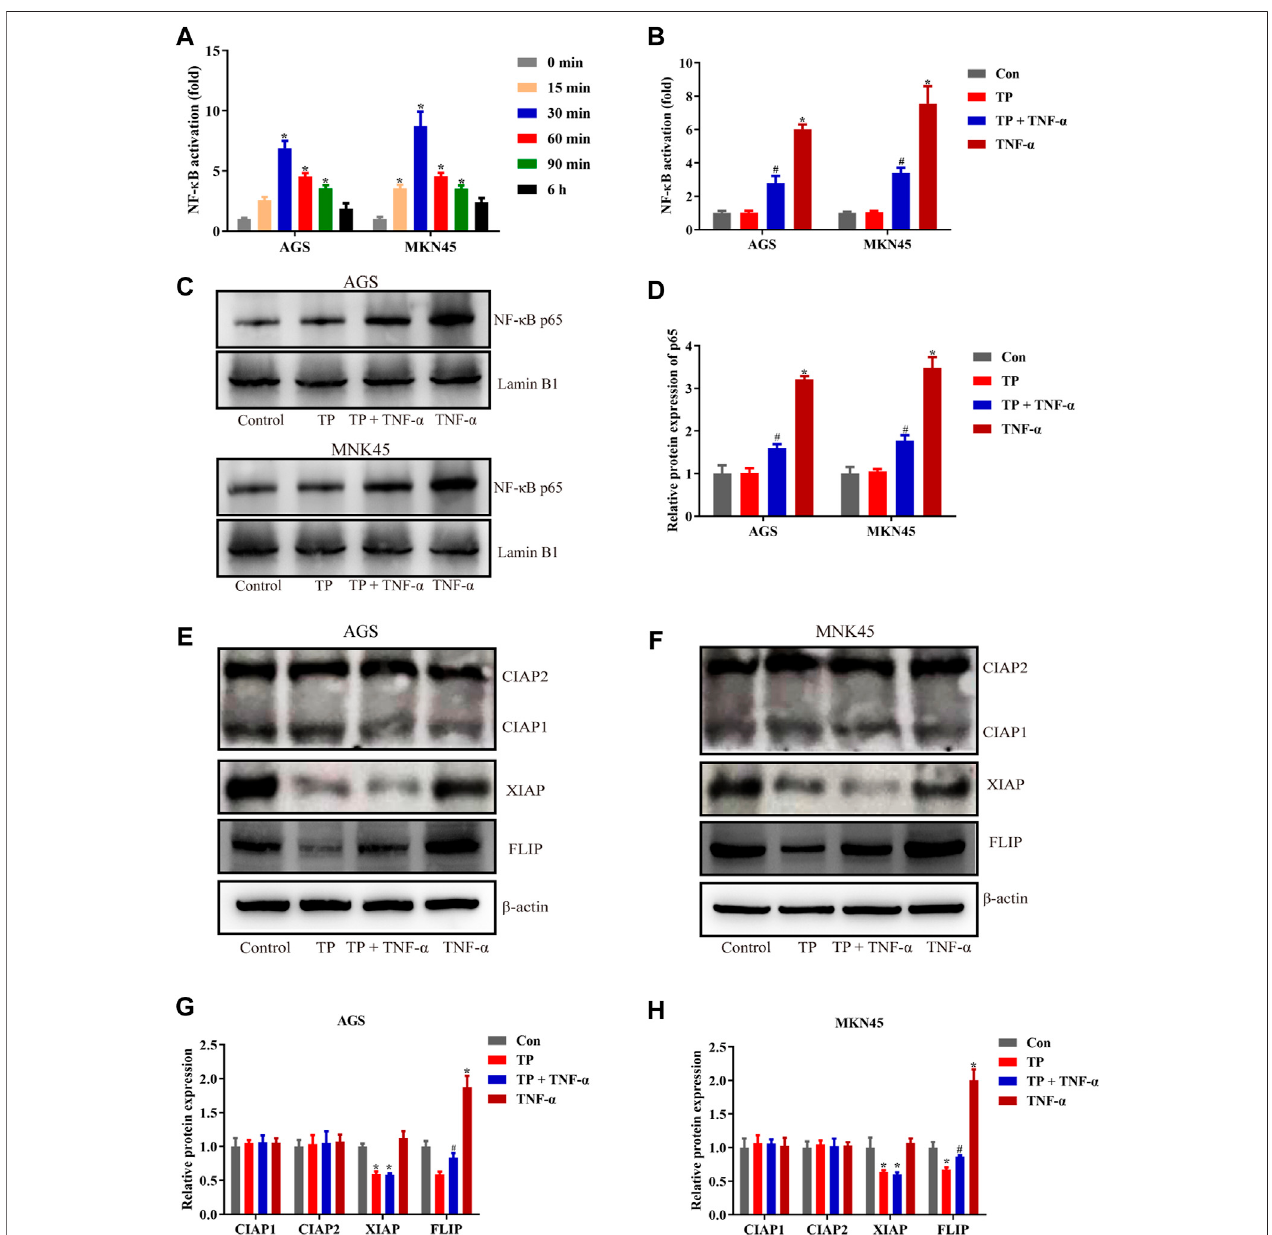
FIGURE 2 | TP treatment inhibited NF- κ B – mediated prosurvival signals induced by TNF- α . (A) Time-dependent NF- κ B activation induced by TNF- α (5 ng/ml). (B) Relative NF- κ B activity induced by TP (25 nM) and TNF- α (5 ng/ml), 30 min after TNF- α treatment. (C – D) Representative western blots and relative intensity of protein bands of NF- κ B p65 nuclear protein, with Lamin B1 as the loading control, 30 min after TNF- α (5 ng/ml) treatment. (E – H) Representative western blots and relative intensityofproteinbandsofCIAP1,CIAP2,XIAP,andFLIPinAGSandMKN45cellstreatedwithTP(25nM)andTNF- α (5ng/ml),24hafterTNF- α application,with β -actin as the loading control. Results were expressed as mean ± SEM, and statistical analysis was performed using one-way ANOVA or two-way ANOVA followed by Tukey ’ s multiple comparison test. * , # p < 0.05 ( n ≥ 3). * p compared with the control group and # p compared with the TNF- α -treated group.